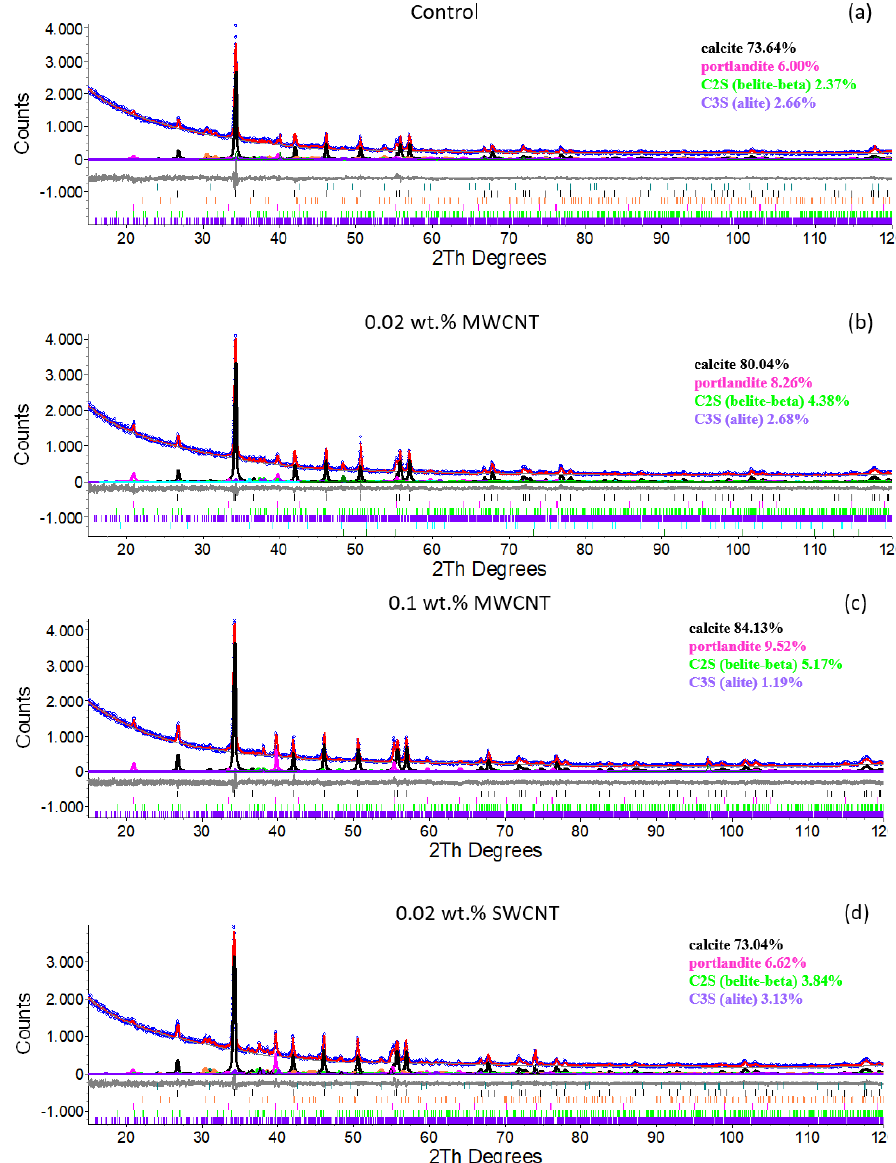
Figure 5. XRD spectra of ( a ) control sample, ( b ) 0.02 wt.% MWCNTs reinforced sample, ( c ) 0.1 wt.% MWCNTs reinforced sample and ( d ) 0.02 wt.% SWCNTs reinforced sample.